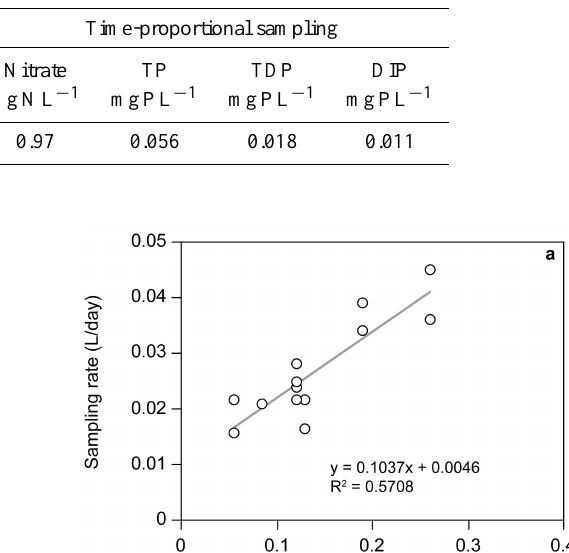
Table 1. Nitrate and phosphorus concentration in the flume experiments determined by SC-samplers and time-proportional sampling. The SC-samplers were installed in the flumes for 1 week ( n = 14). Concentrations ± standard error.